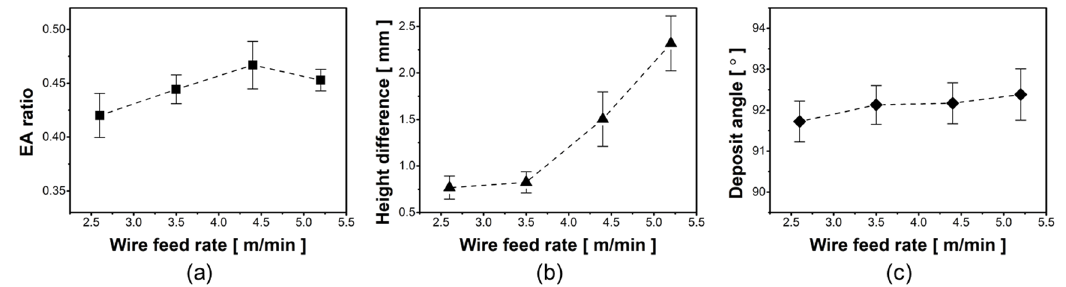
Figure 4. Experimental results depending on the wire feed rate: ( a ) the effective area (EA) ratio, ( b ) height difference, and ( c ) deposit angle.